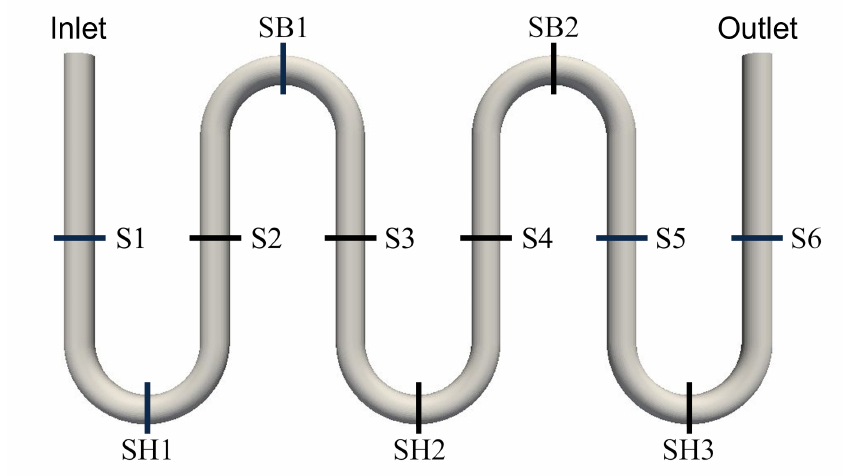
Figure 6. Schematic of the different sections of interest.